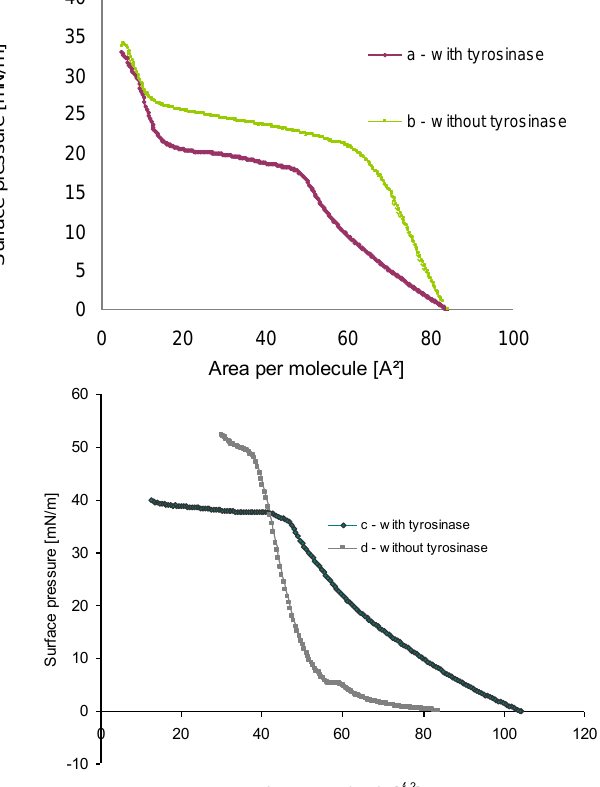
Figure 4. Surface pressure—area isotherms of tyrosinase incorporated in linoleic acid (LA) – a , or phospholipids − c layer and protein free film b, d at 295 K on HEPES buffer (pH 6.52); 4a